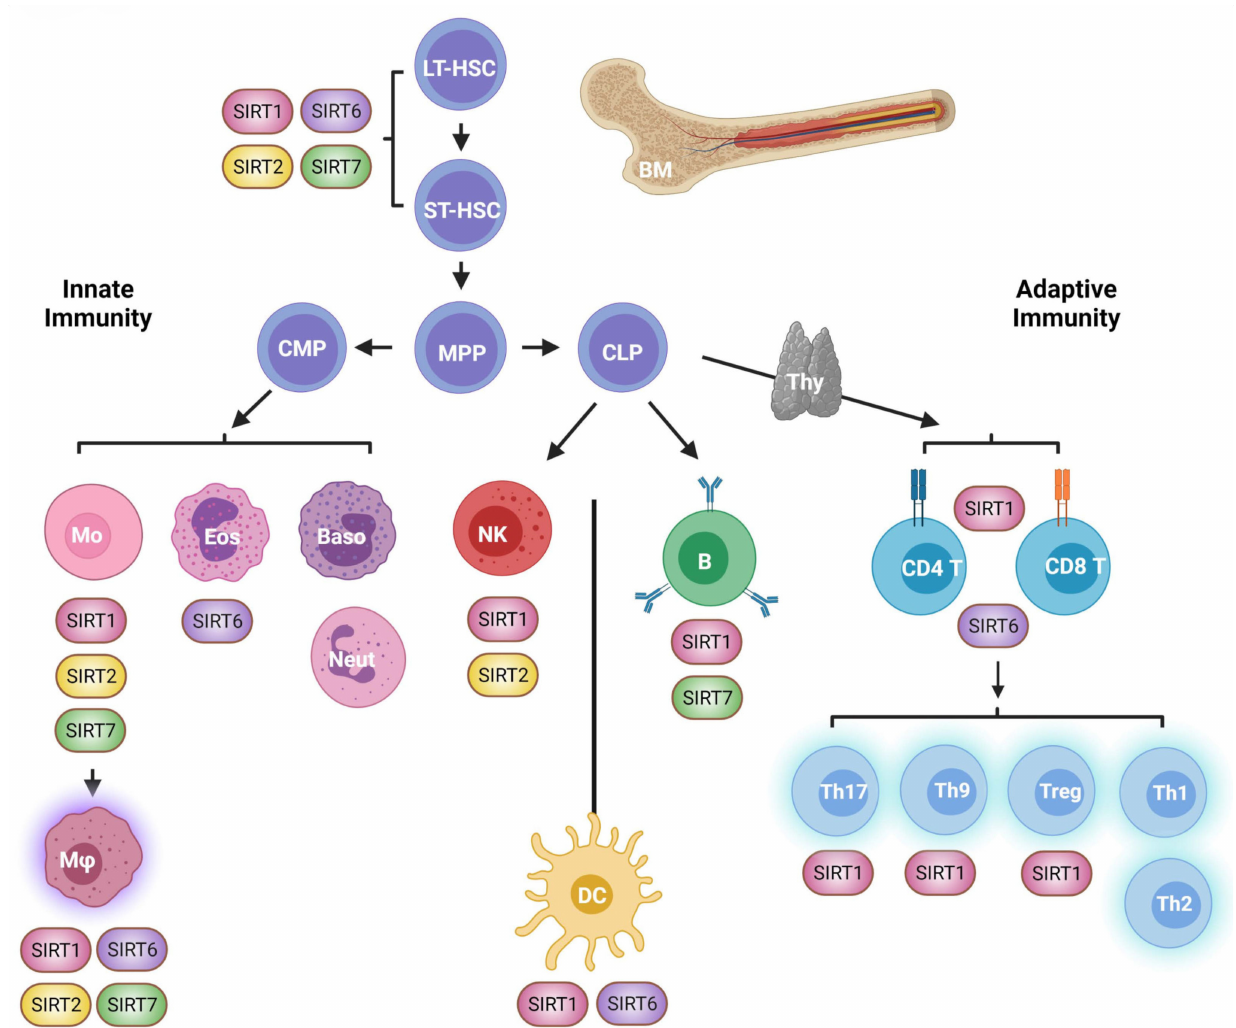
Figure 2. Overview of immune system ontogeny and its relationship with nuclear sirtuin activity. Hematopoiesis starts in the bone marrow through sequential differentiation of hematopoietic stem cells (HSC) into different immune cell progenitors (upper part). Innate immune cells originate from a common myeloid progenitor (MCP) and involve a variety of immune cell types including monocytes (Mo), macrophages (M ϕ ), eosinophils (Eos), basophils (Baso), and neutrophils (Neu) (left lower part). Common lymphoid progenitors (CLP) give rise to B cells in the bone marrow and T cells in the thymus (thy) (right lower part). Natural killer (NK) cells, despite having a lymphoid origin, play important roles in innate immunity against tumors and viral-infected cells. Dendritic cells (DC) have a lymphoid and myeloid origin (not shown in this figure) and sit at the interphase of innate and adaptive immunity. Sirtuins icons denote sirtuin cell type-specific roles. ST-HSC: short-term HSC; LT-HSC: gong-term; MPP: Multipotent progenitor. Figure created with